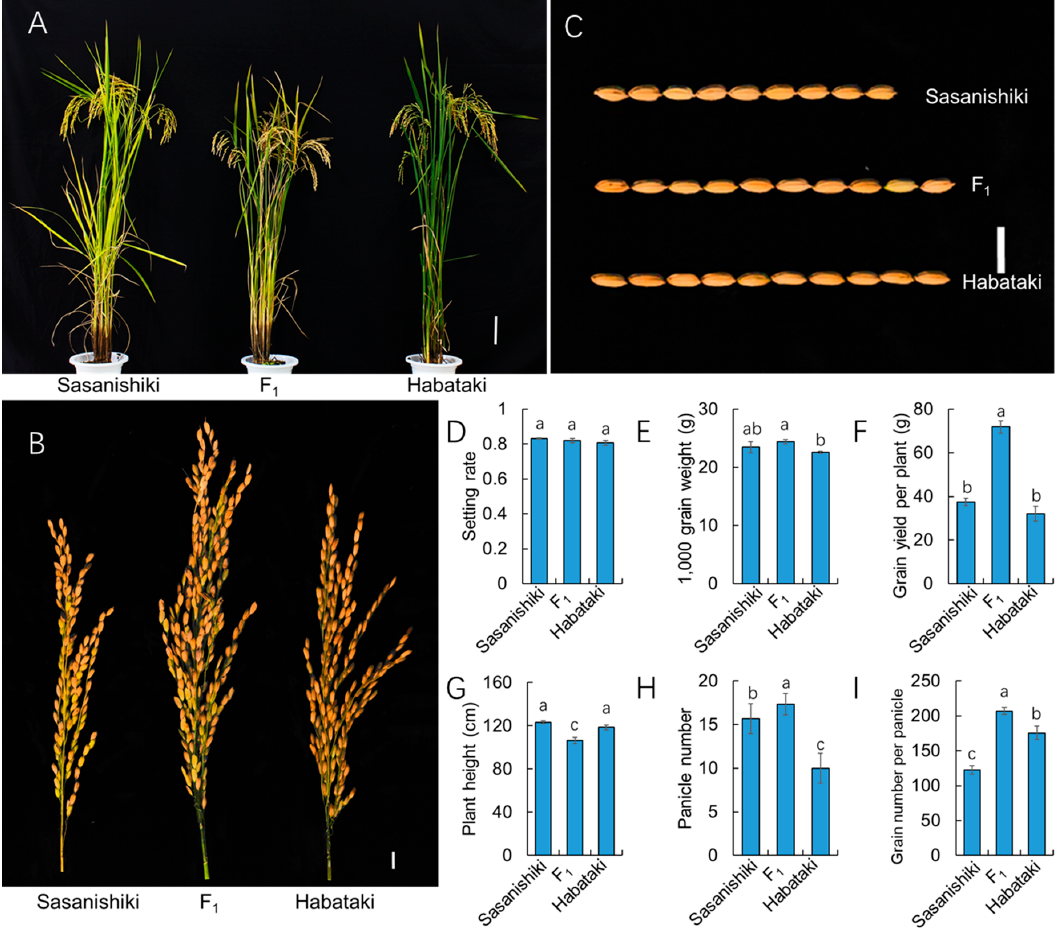
Figure 2. Heterosis in F 1 plants. ( A ) The plant architecture of F 1 plant and parental lines. Scale bar = 10 cm. ( B ) The panicle of F 1 plants and parental lines. Scale bar = 1 cm. ( C ) Grains of F 1 plants and parental lines. Scale bar = 10 cm. ( D – I ) the yield-related traits of F 1 plants and parental lines.